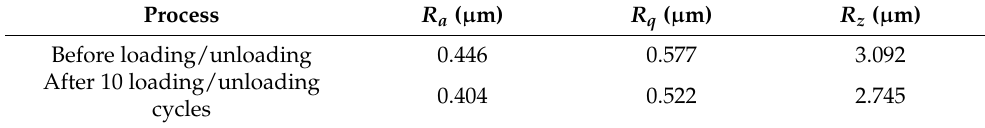
Table 1. Roughness measured before loading/unloading and after 10 loading/unloading cycles.